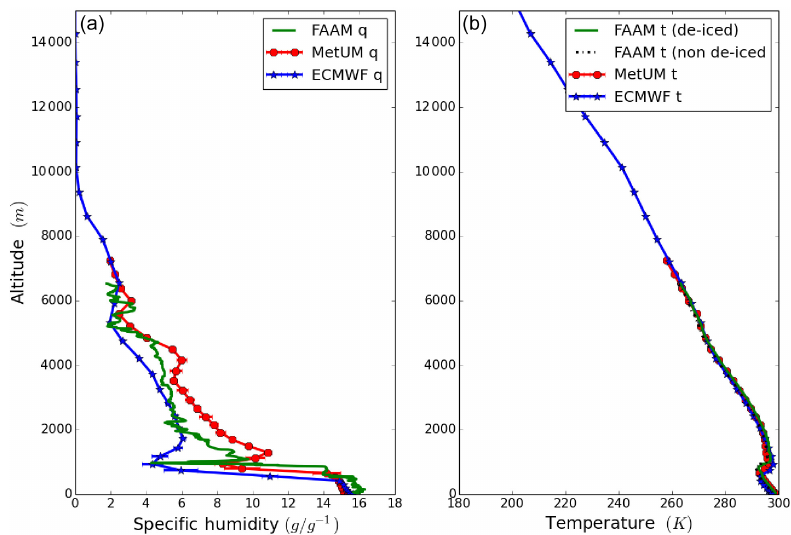
Figure 7. Case study 1, B920, 7 August, P2. (a) Water vapour mixing ratio from the aircraft measurements in the profile (green) compared with the MetUM (red) and ECMWF (blue). (b) The same but for temperature – here there are two measurements of temperature shown, which are in good